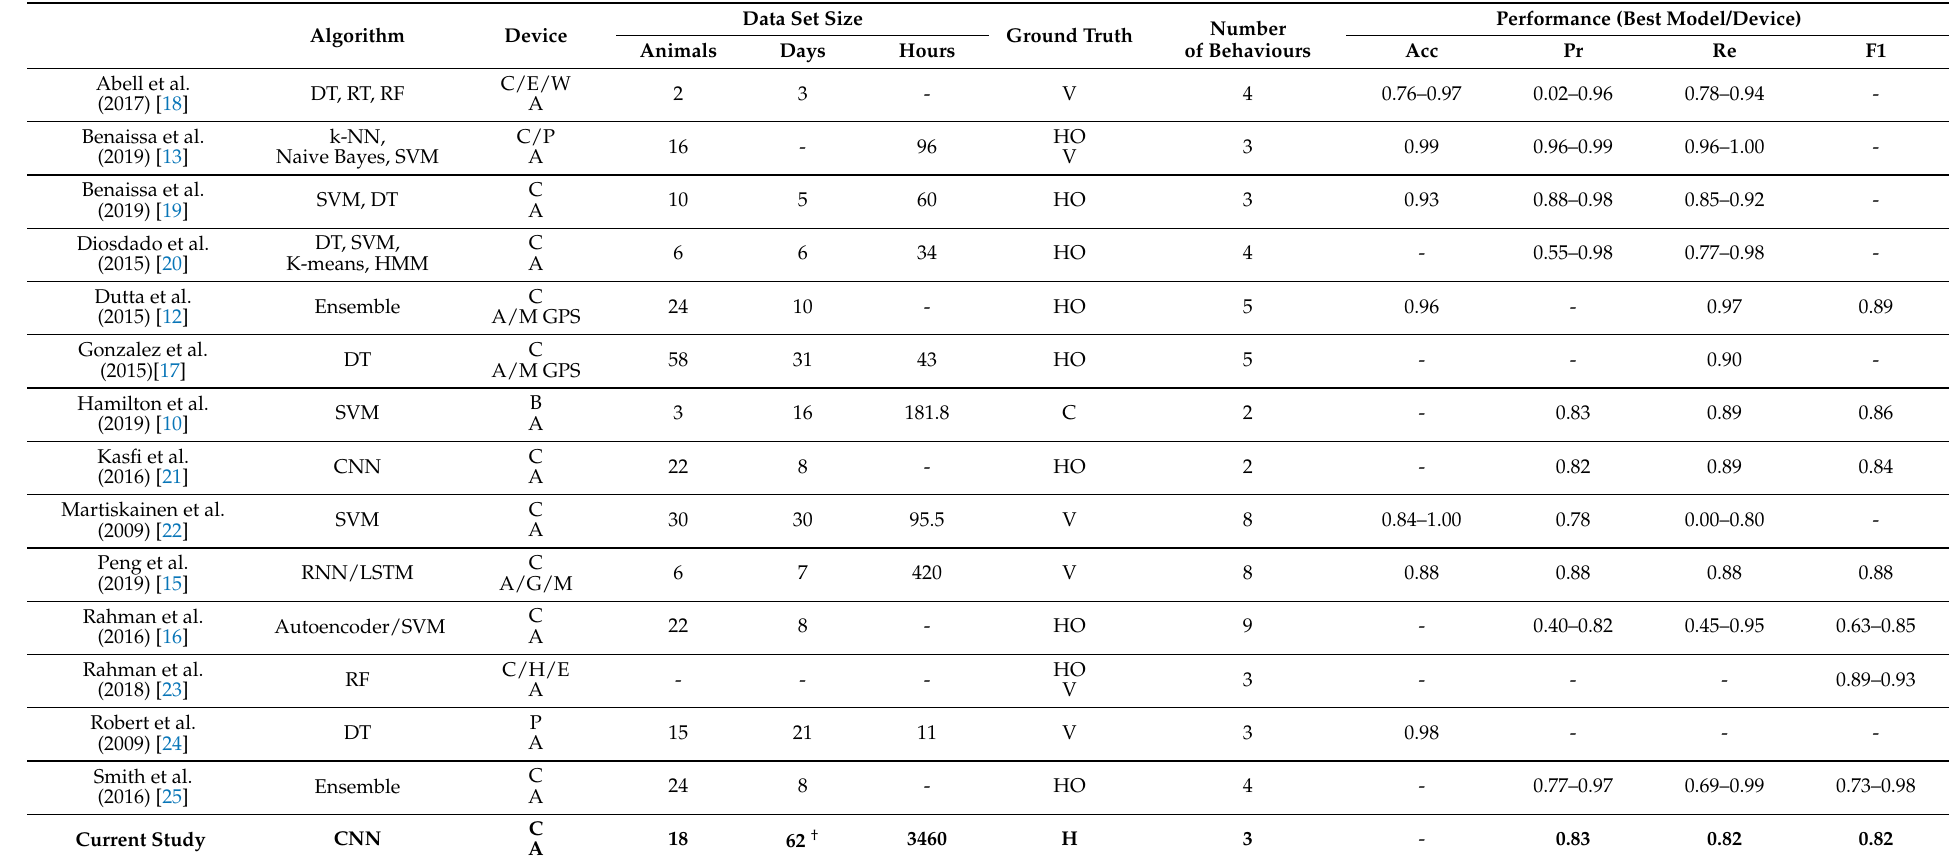
Table 1. Comparison of published literature on cattle behaviour